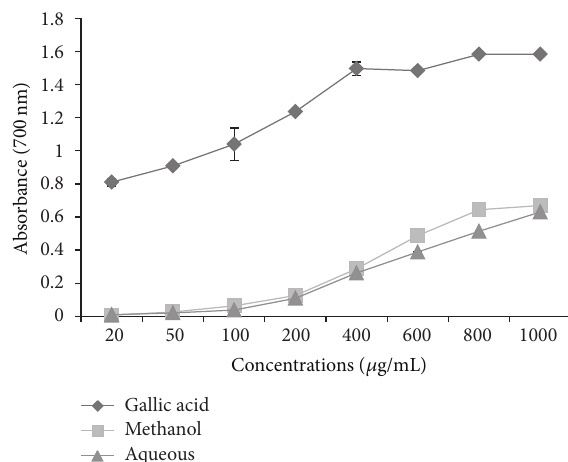
Figure 4: Hydroxyl radical scavenging activity (-EDTA) of P. aculeata L. and gallic acid (results are represented as mean ± SE of triplicate